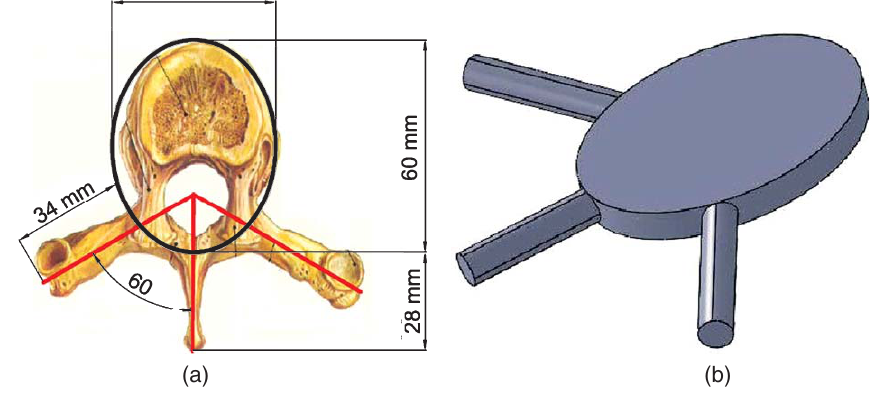
Fig. 6. Geometrical figure of a vertebra: (a) Average dimensions; (b) A CAD model.